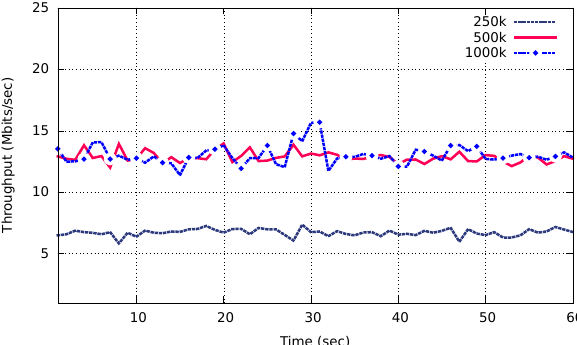
Figure 9. OpenEPC UE throughput in different TCP window